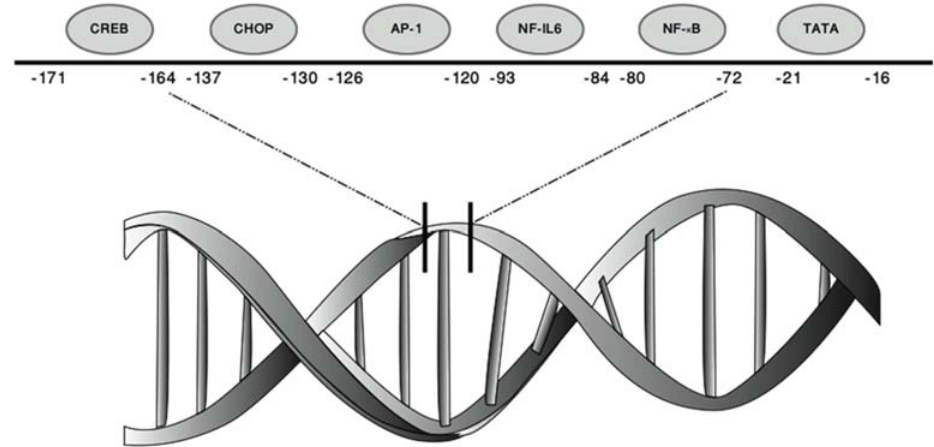
Figure 1. Architecture of the interleukin-8 promoter. Graphic representation of the CXCL8 promoter showing the locations of the binding sites for transcription factors that induce its expression (adapted from reference